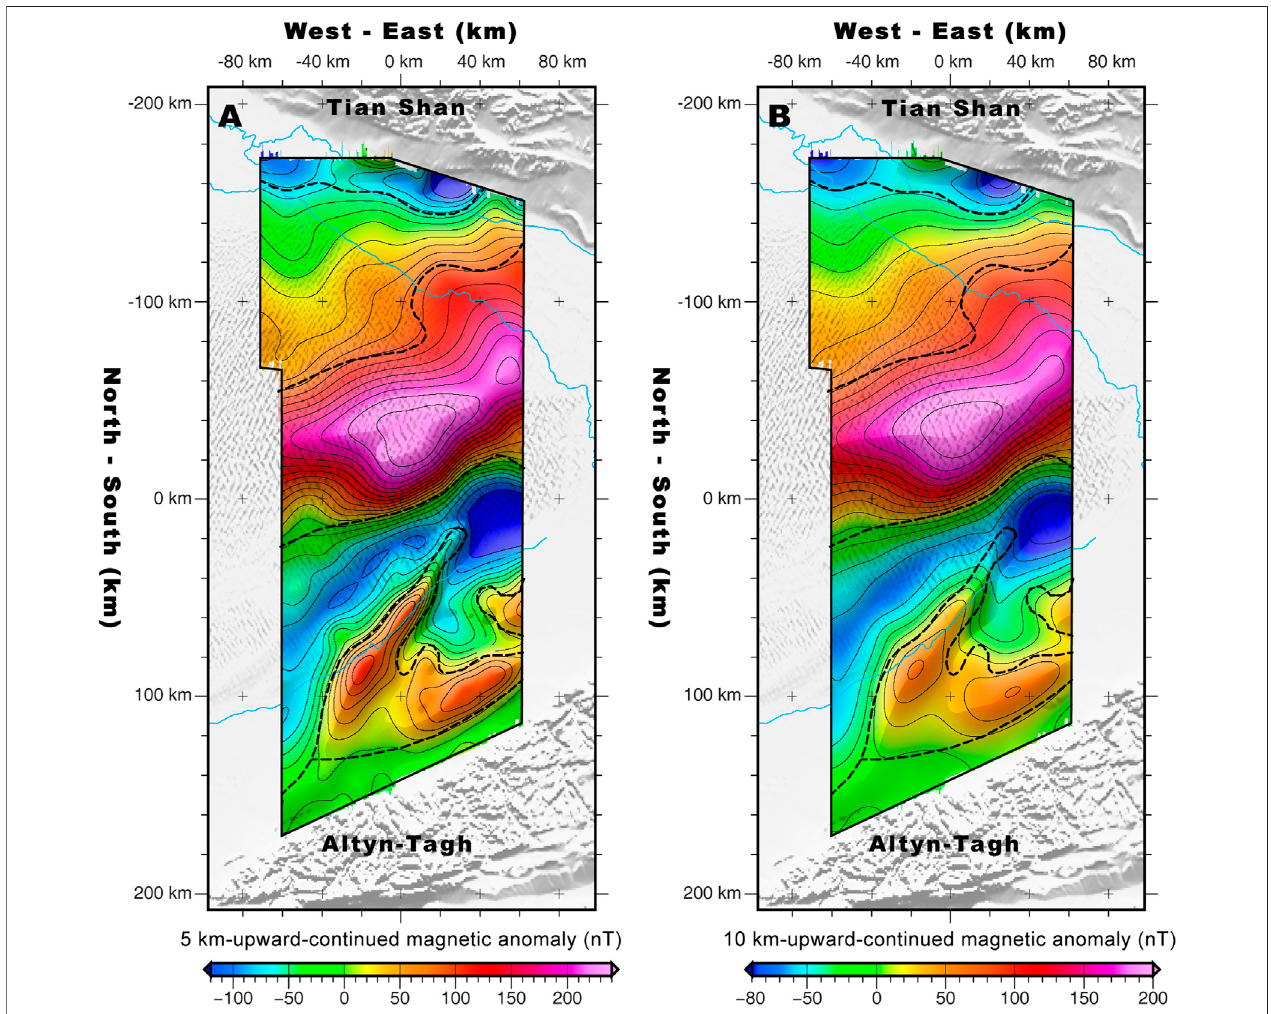
FIGURE 6 | Map of upward continuation to (A) 5 km and (B) 10 km of magnetic anomalies (RTP), and the boundaries of subregions of magnetic anomalies.